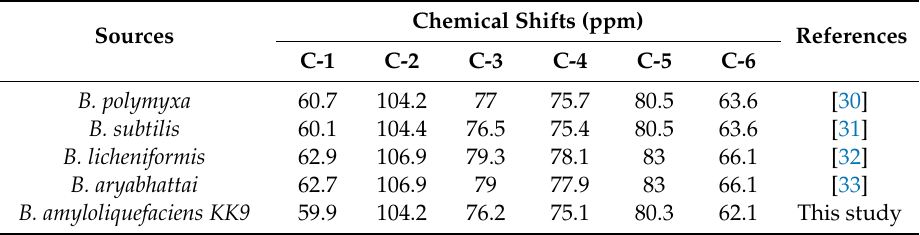
Figure 3. ( A ) 1 H-NMR and ( B ) 13 C-NMR spectrum of the polymer synthesized by wild-type LsKK9. Table 1. Comparison of the 13 C-NMR chemical shifts of the levan produced from different bacterial sources.